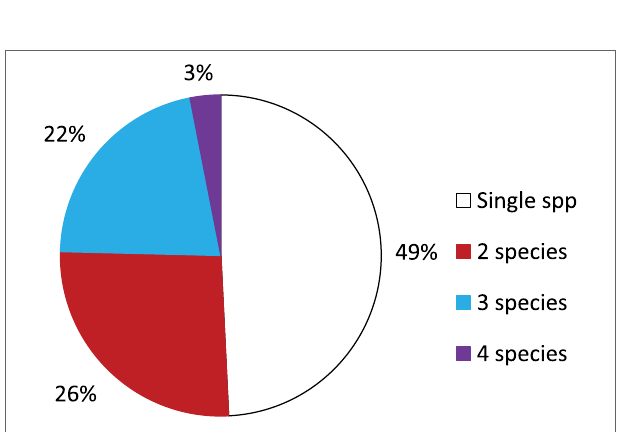
FigUre 5 | Percentage of containers breeding a single, two, three or four species of mosquito within individual containers.